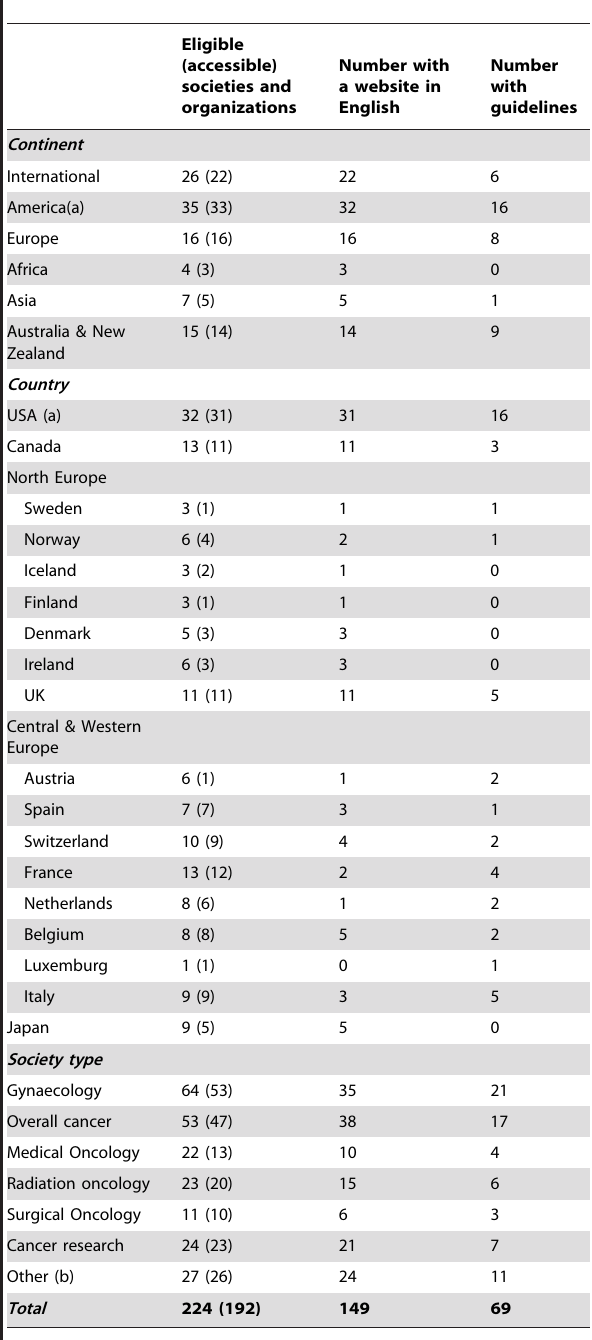
Table 1. Distribution of organizations by location, society and organization